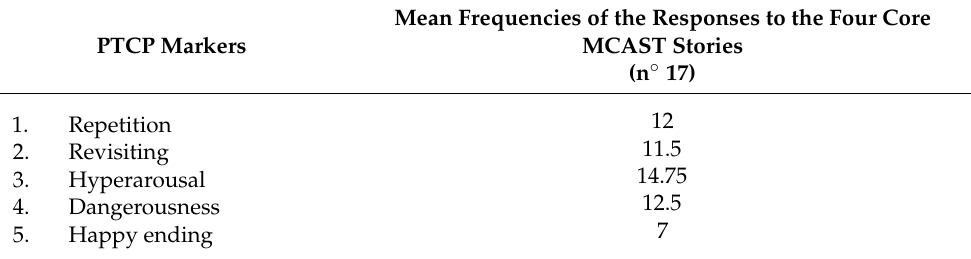
Table 3. Mean frequencies of post-traumatic child's play (PTCP)